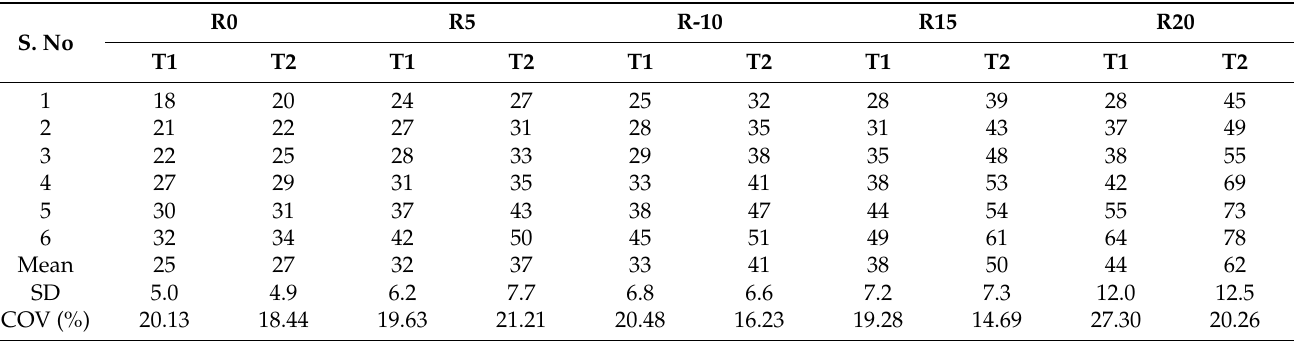
Table 2. Impact test results for non-fibrous specimens.